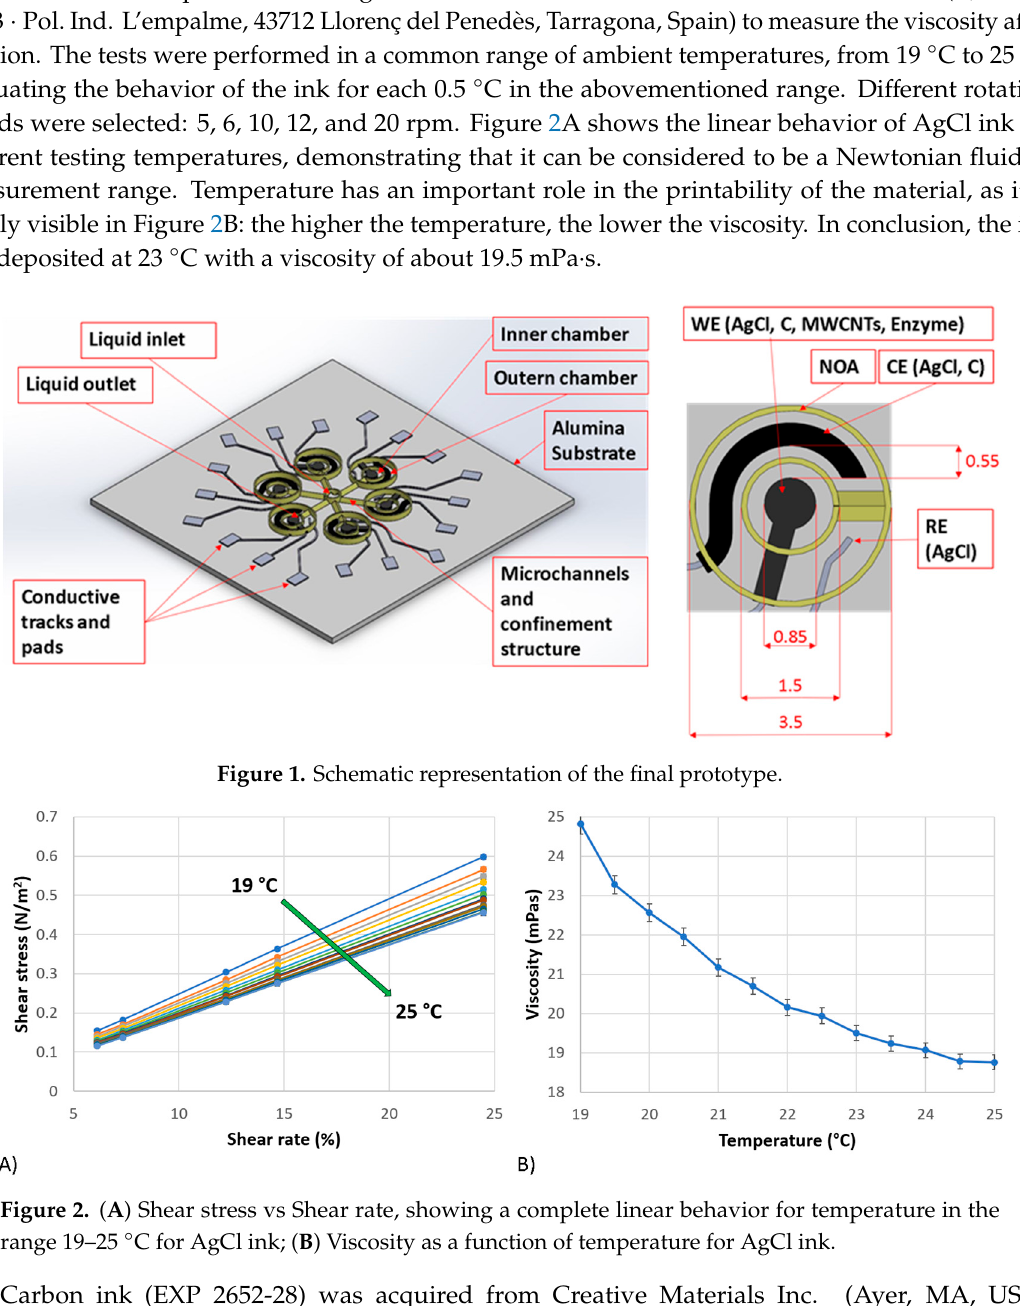
Figure 1. Schematic representation of the final